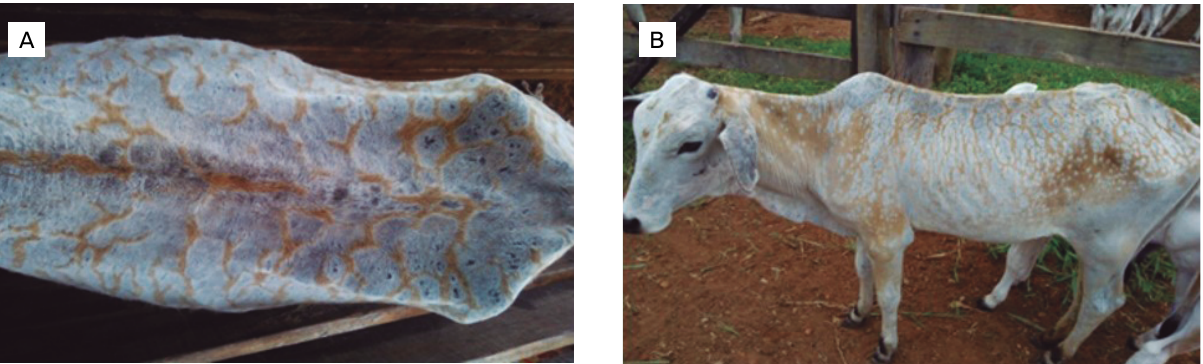
Figure 3. Outcome of generalized cutaneous lesions caused by Dermatophilus congolensis in a calf after three weeks of treatment with oxytetracycline. (A) Detail of animal dorsum showing various round resolved lesions. (B) Aspect of general re-epithelialization of the lesions. Botucatu, SP, Brazil,